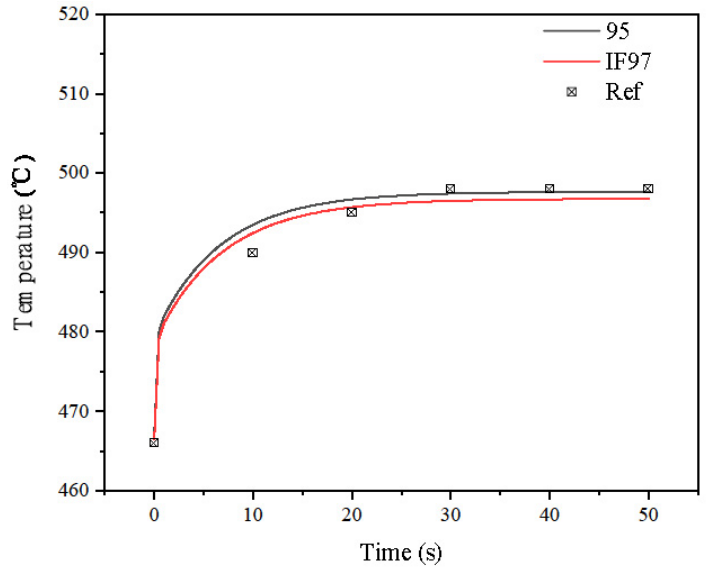
Figure 8. The outlet water temperature results of a 2% step increase in inlet helium temperature.